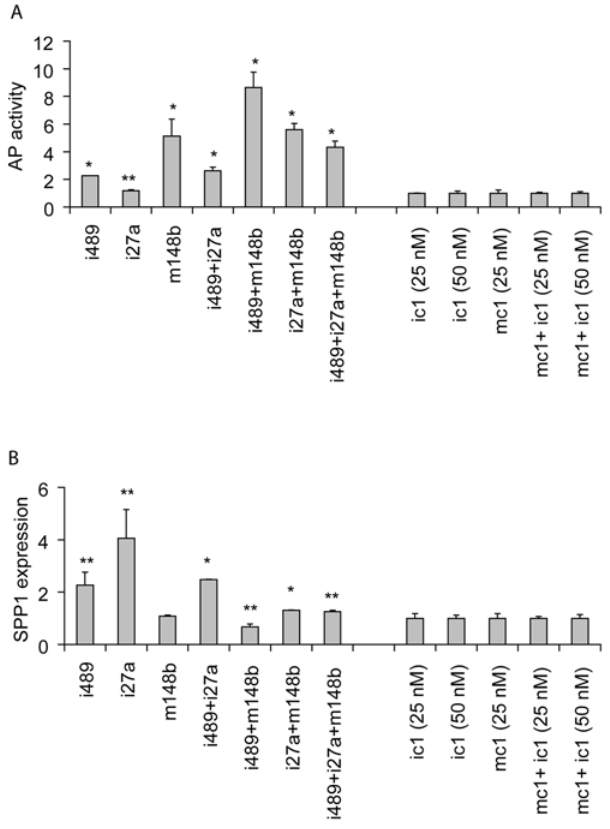
Figure 2. Adjustment of the miRNAs activity alone induced osteogenic differentiation of hMSC in the absence of other differentiation stimuli. Cells transfected with miRNA inhibitors or mimics alone or in combination, demonstrated drastic increase in total AP activity (A), and up-regulation of SPP1, another marker of early ostogenesis (B) . Data are representative of three independent experiments performed in triplicate. (mean + / 2 SD). *, **: Student’s ttest p value between treated cells and corresponding control group, * - p , 0.01, ** - p , 0.05.